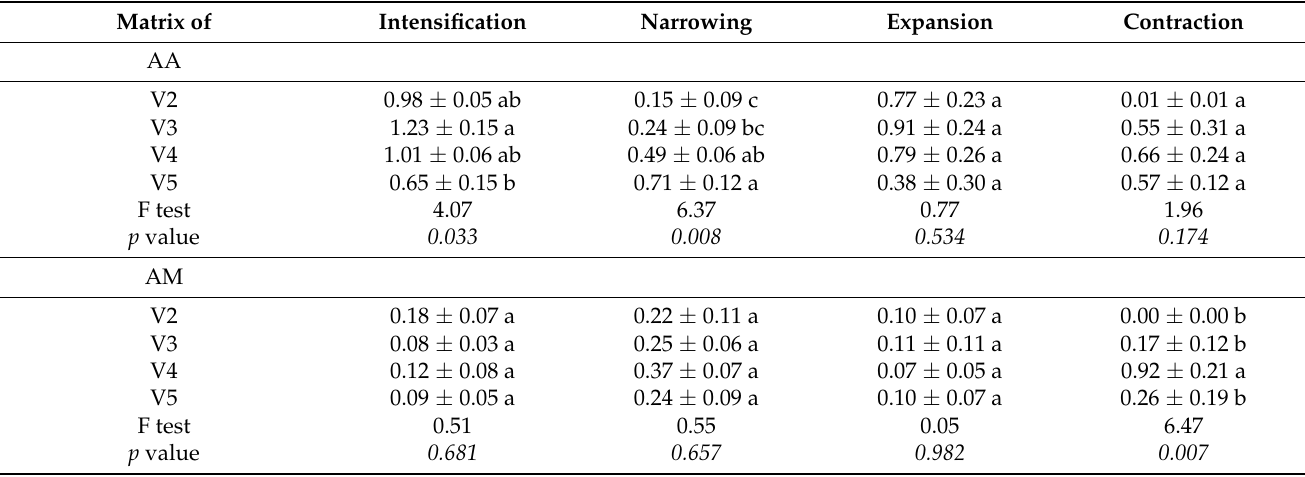
Figure 2. PCA of complementary segments of ecological niche associated with microbial community physiological profile due to the application of treatments. Variance explained by axis for each PCA in brackets. ( a ) Intensification (Axis 1 − 20.93%, Axis 2 − 16.49%); ( b ) Expansion (Axis 1 − 35.94%, Axis 2 − 14.24%); ( c ) Narrowing (Axis 1 − 22.60%, Axis 2 − 17.20%); ( d ) Contraction (Axis 1 − 27.47%, Axis 2 − 25.48%). Table 2. Changes in Functional Microbiome, Guild Association, and Group Dominance–Codominance due to treatments.